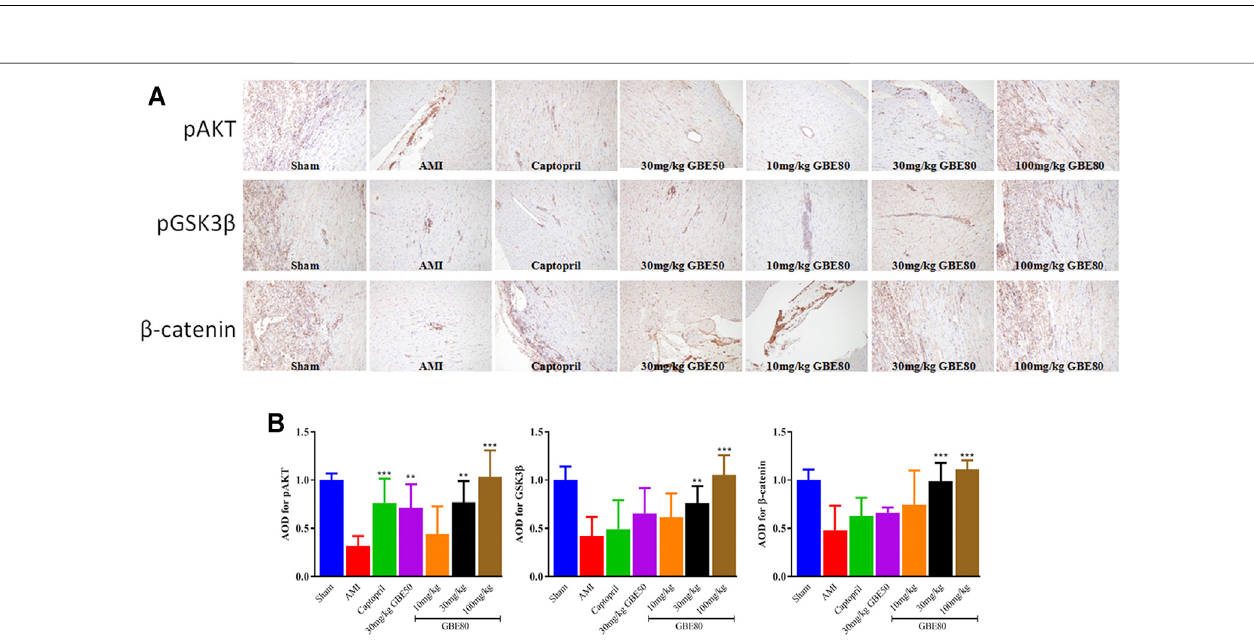
FIGURE5| ExpressionsofpAKT,pGSK3 β and β -catenin intheleftventricle detected byimmunohistochemicalstaining. (A) Representativeimmunohistochemical staining obtained from left ventricles of several groups with pAKT, pGSK3 β and β -catenin detection ( × 100). (B) Quantitative statistical analysis of AOD values using Image-Pro Plus software. (**, *** indicates p < 0.01, p < 0.001 vs the AMI group, respectively).